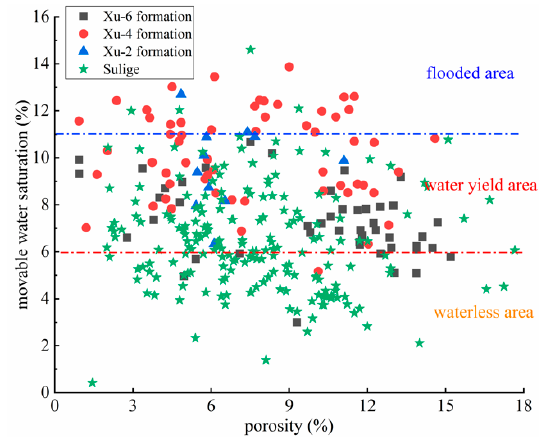
Figure 11. Movable water saturation versus porosity in tight sandstone cores.